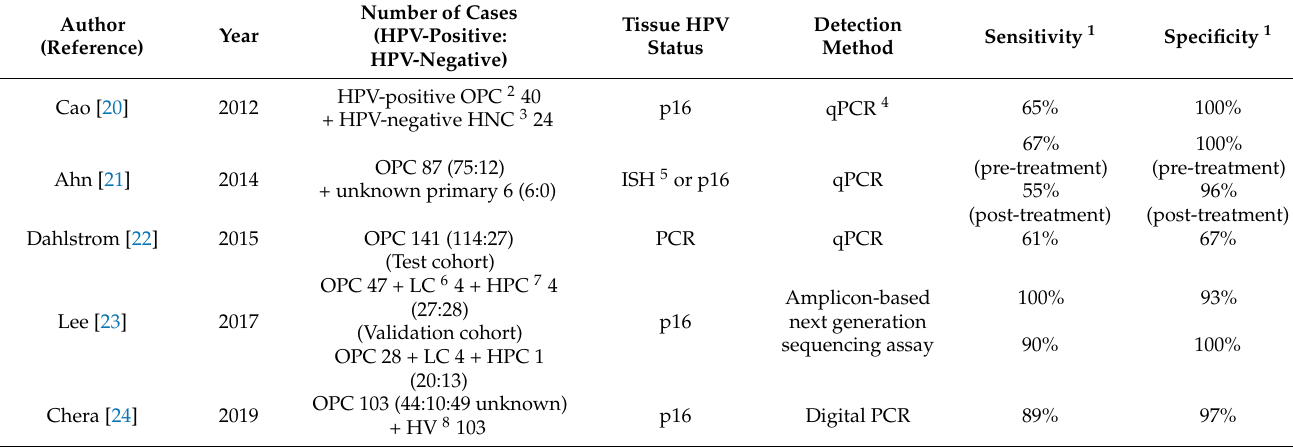
Table 1. HPV DNA detection in pre- and/or post-treatment plasma in oropharyngeal cancer patients.